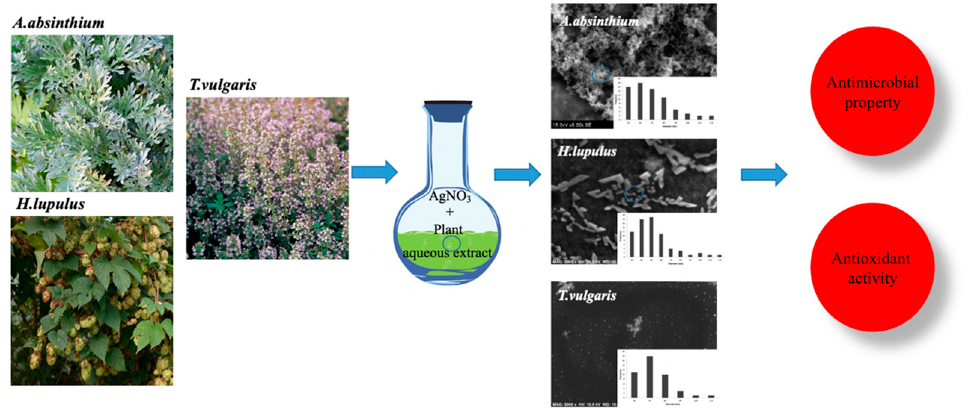
Figure 1. Graphical abstract representing the overview of paperwork with key highlights.